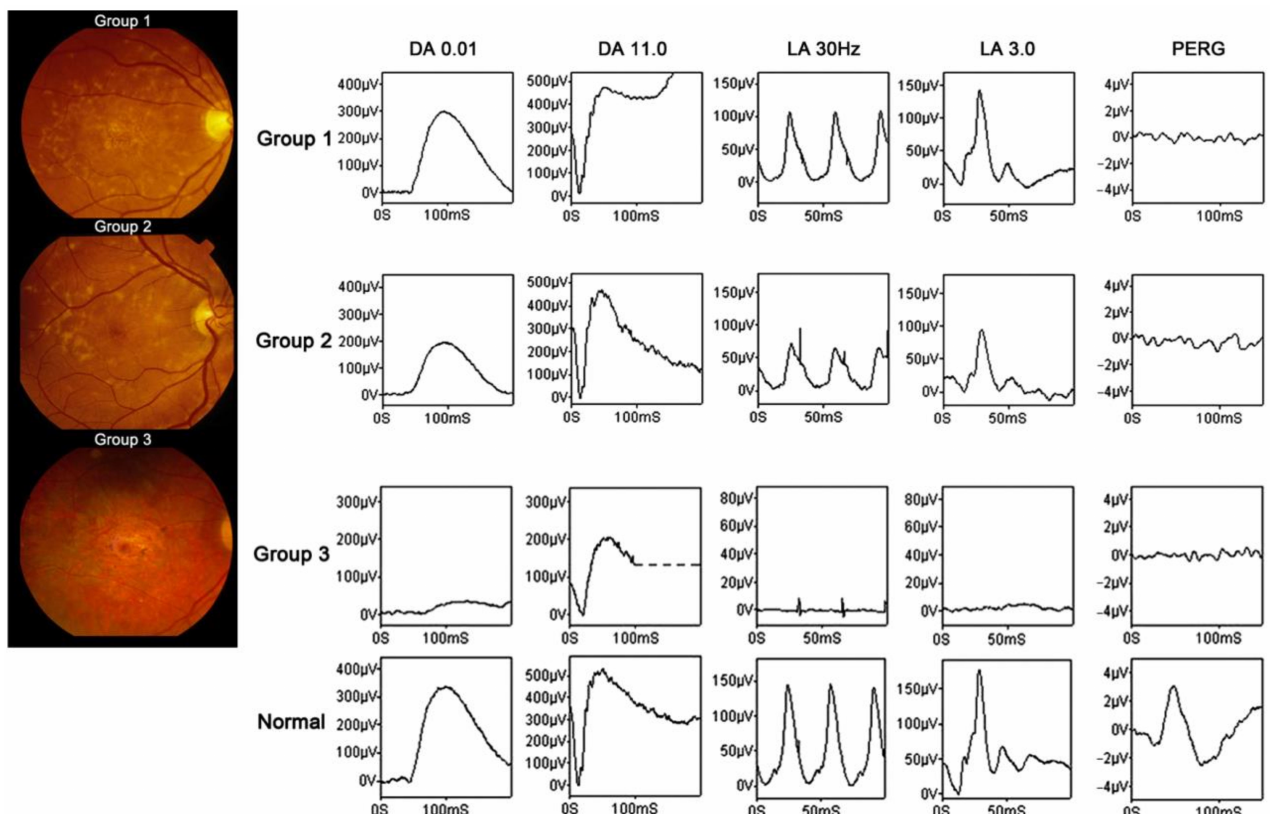
Figure 1. Representative fundus photos and electrophysiological findings in different groups of STGD1 (Adapted from Fujinami et al. 2013 with permission [26]). In Group 1, ffERG cone responses are mildly reduced and rod responses are normal, while PERG is reduced severely. In Group 2, ffERG cone responses are reduced moderately and rod responses are reduced mildly, while PERG is reduced severely. In Group 3, ffERG cone and rod responses are reduced severely, while PERG is reduced